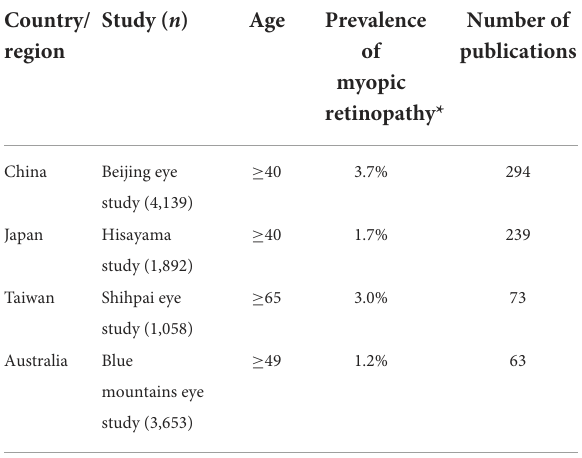
TABLE 4 The population-based prevalence of myopic retinopathy and the number of publications since 2020.